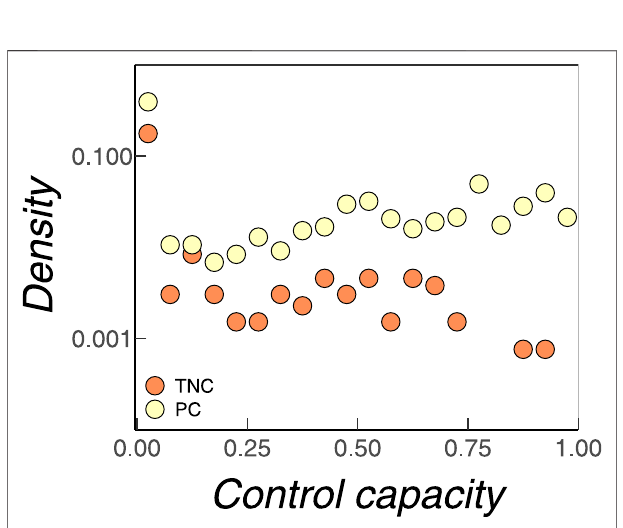
FIGURE 3 | Distribution of (B) the number of TNCs, and (B) their total operating revenue (in trillion USD) sampled from 10.000 MDSs.